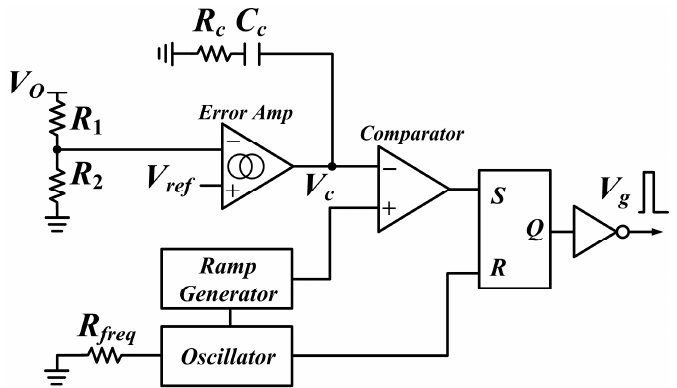
Figure 8. Block diagram of the control circuit for the proposed converter.